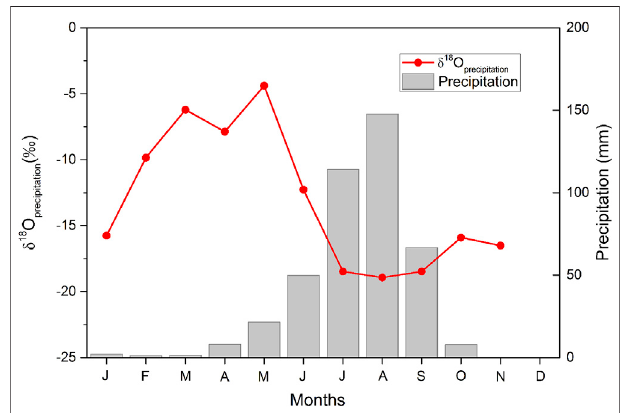
FIGURE 5 | Monthly precipitation amounts and weighted-average δ 18 O of precipitation at Lhasa station (data are from Liu et al., 2007; Gao et al.,